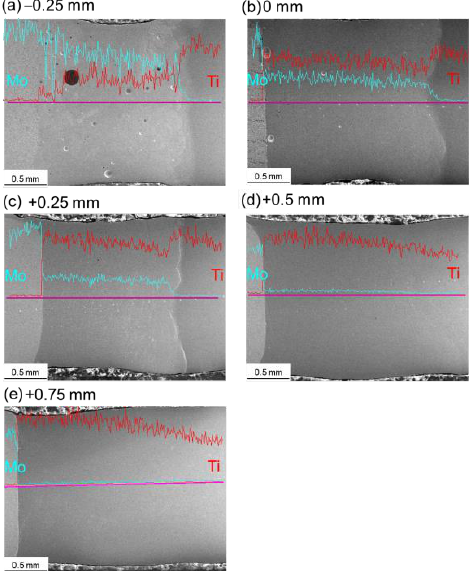
Figure 7. Map scanning results of element distribution for Mo/Ti joints obtained at various laser beam offsets. ( a , d , g , j , m ), the SEM image of scanning area of joints −0.25 mm, 0 mm, +0.25 mm, +0.5 mm, +0.75 mm respectively; ( b , e , h , k , n ), Mo distribution of joints −0.25 mm, 0 mm, +0.25 mm, +0.5 mm, +0.75 mm respectively; ( c , f , i , l , o ), Ti distribution of joints −0.25 mm, 0 mm, +0.25 mm, +0.5 mm, +0.75 mm respectively.